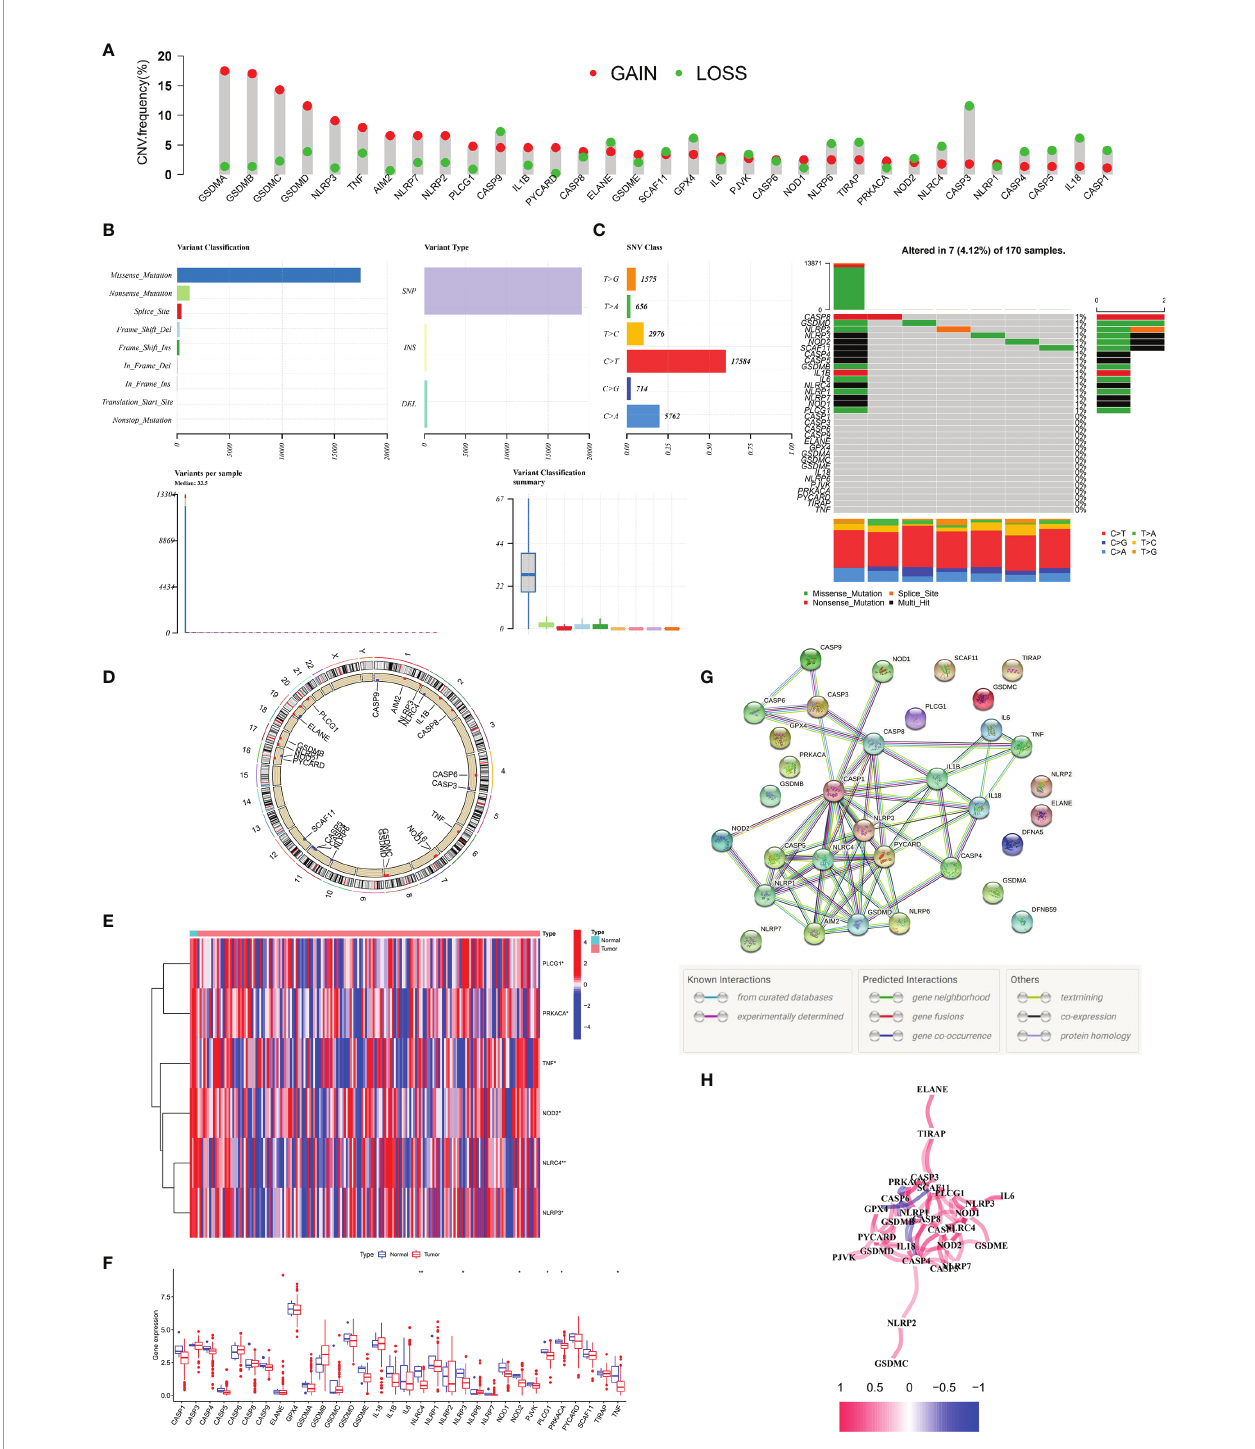
FIGURE 1 | Landscape of 33 PRGs in the PC cohort. (A) The CNV alteration of 33 PRGs in the PC cohort. The height of the column represents the alteration frequency. (B, C) The mutation frequency along with the classi fi cation of 33 PRGs in PC. PRG: pyroptosis-related gene, PC: pancreatic cancer, SNP: single- nucleotide polymorphism, INS: insertion, and DEL: deletion. (D) The position of 33 PRGs on the chromosome. (E) Heatmap (blue: low expression level; red: high expression level) of PRGs between normal (N, brilliant blue) and tumor tissues (T, red). (F) Comparison of the gene expression of 33 types of PRGs between normal and tumor tissues in TCGA cohort. (G) PPI network illustrating the cross talks of PRGS (cross talk score = 0.9). (H) The association network of PRGs (red line: positive association; blue line: negative relationship). The depth of colors re fl ects the strength of relevance). *P < 0.05; **P <